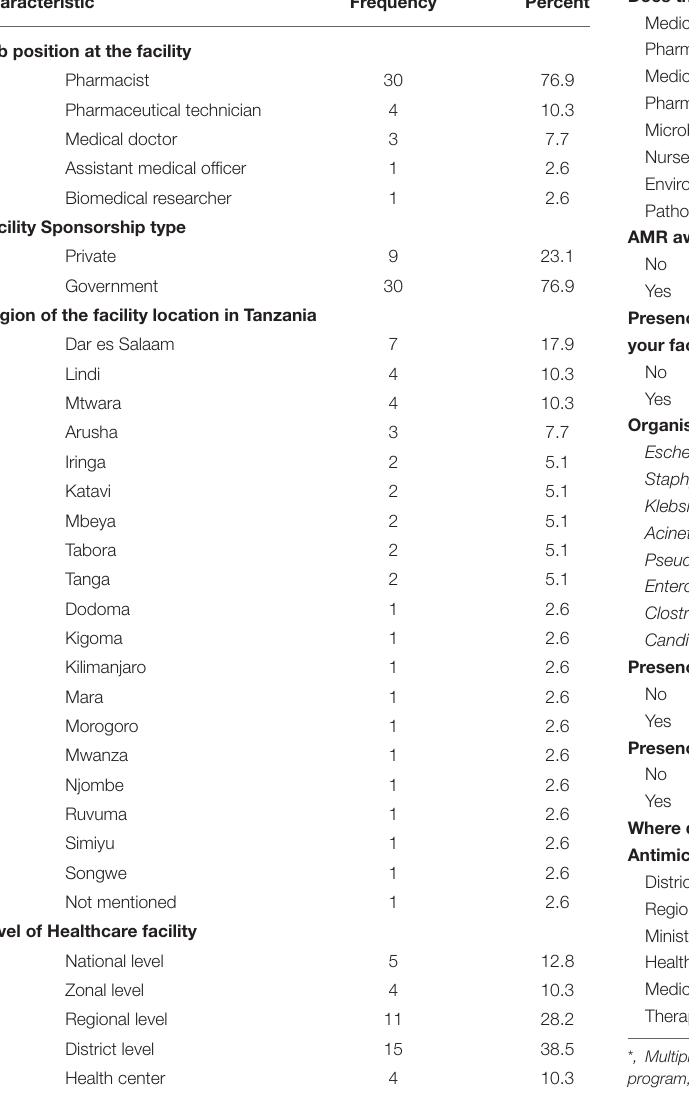
TABLE 1 | Respondents personal and health facility